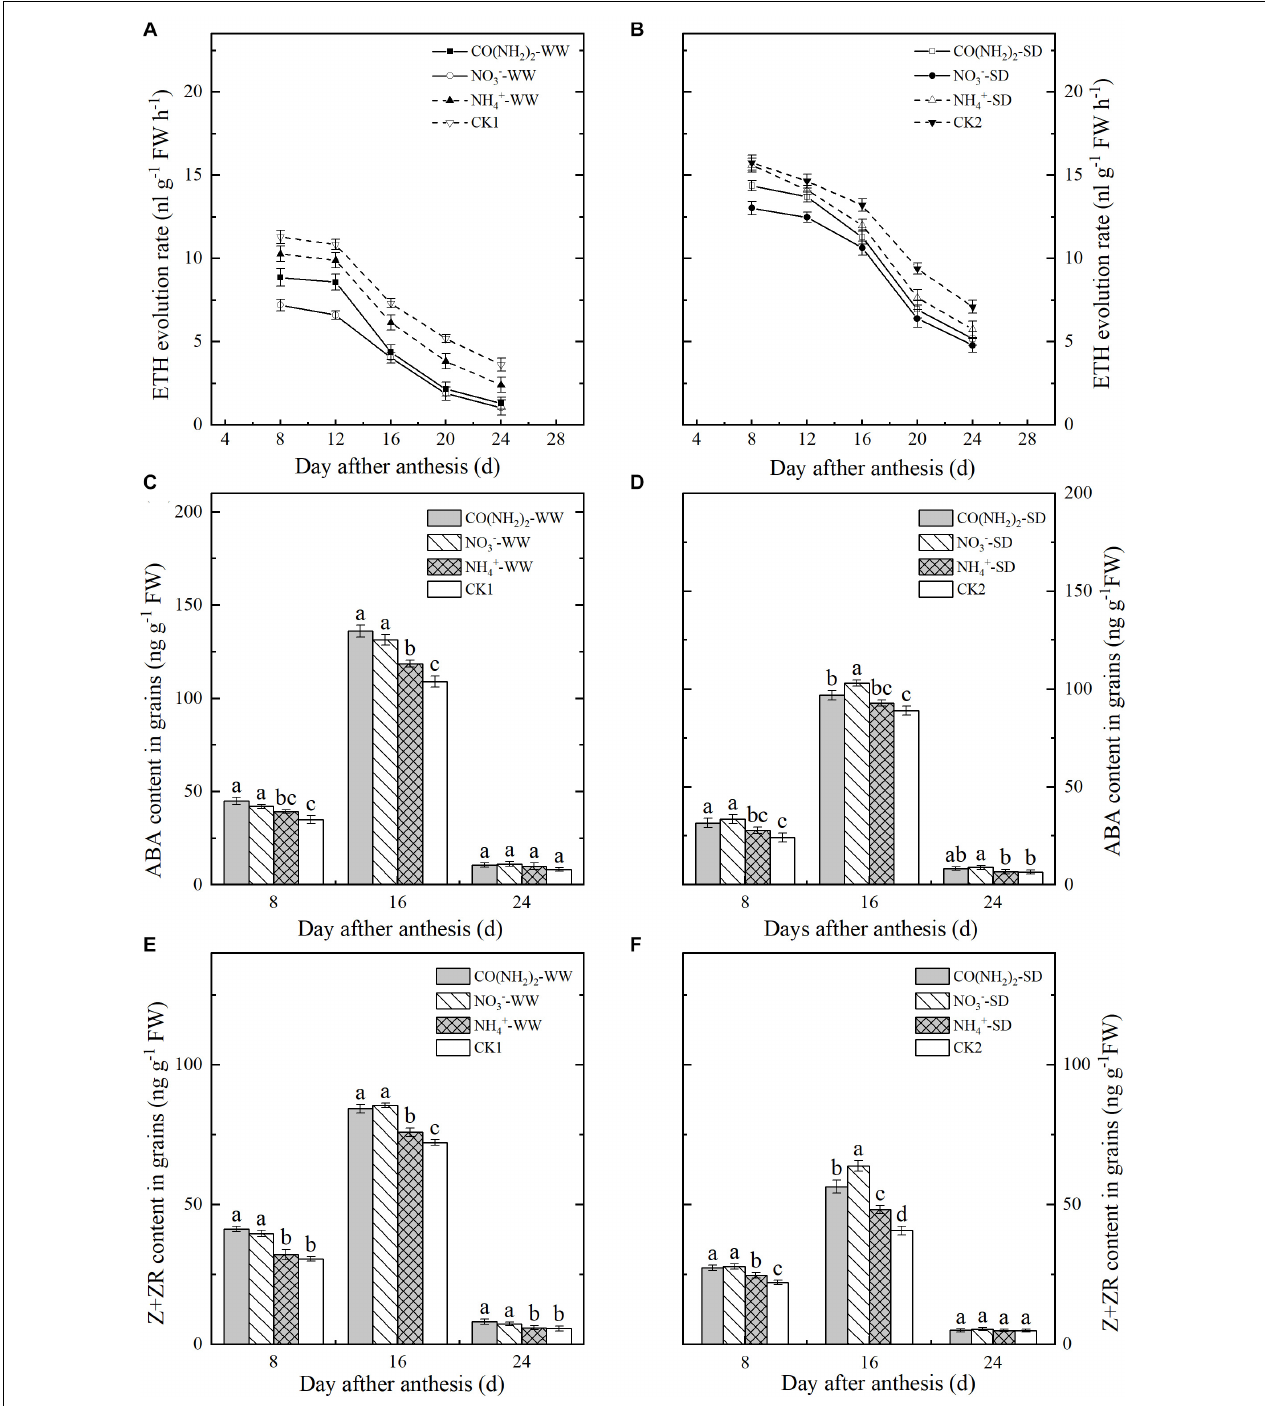
FIGURE 4 | Effect of N forms in foliar fertilizer on the ETH revolution rate, ABA, and Z+ZR content in the wheat grains [ (A,C,E) well-watered treatment, WW; (B,D,F) soil-dried treatment, SD]. Vertical bars represent ± the standard deviation of the mean ( n = 3). Values followed by the same letters in each soil moisture are not significantly different at P < 0.05 level. CO(NH 2 ) 2 , NO 3 − , and NH 4 + represent CO(NH 2 ) 2 , NaNO 3 , and NH 4 Cl, whose concentration was described in the Materials and Methods section. CK1 and CK2 mean that deionized water was sprayed on leaves at anthesis under well-watered treatment and soil-dried treatment,